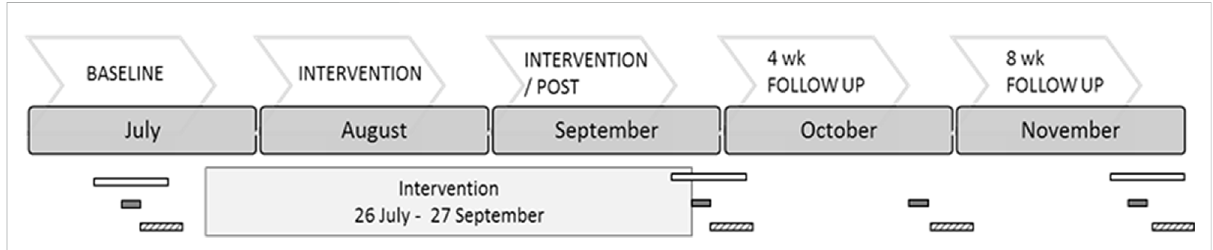
FIGURE 2 Research timeframe. The bars indicate where various measurements took place, and the interval for measurement. Open bars indicate the period for blood collection, solid bars indicate where arterial stiffness measurements were taken (over 1 week end), and striped bars outline where fi tness assessments were measured (over 1 week, immediately following the arterial stiffness